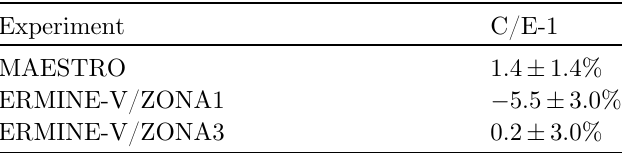
Table 2. C/E-1 for the 103 Rh